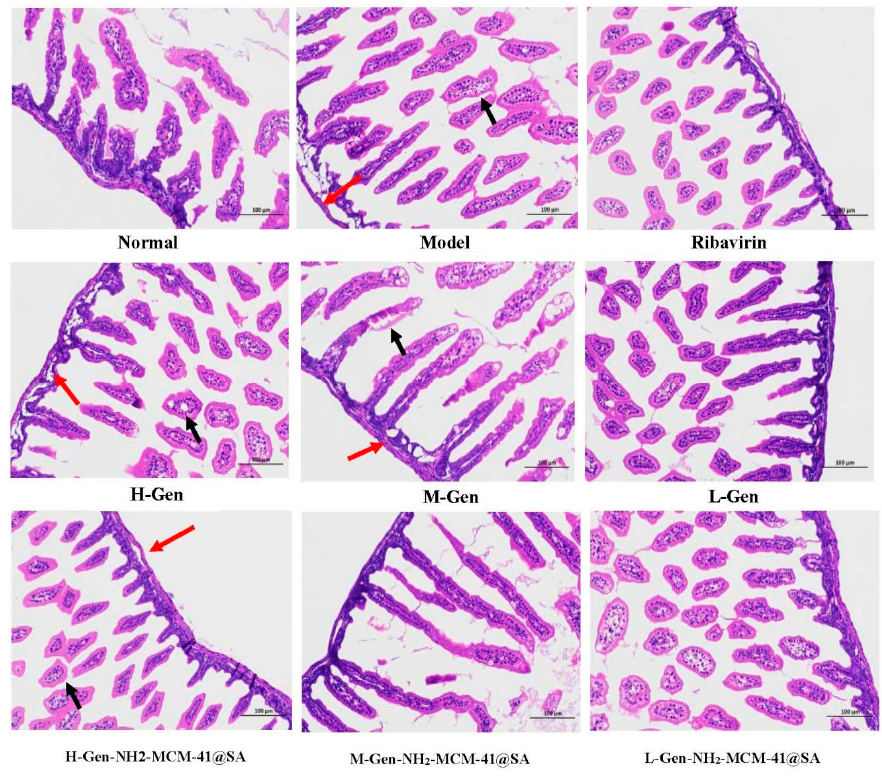
Figure 20. Cross-section of small intestine tissue of different groups of suckling mice on the third day after administration. (red arrows: a few rounded vacuoles can be seen; black arrows: cytoplasm loose).